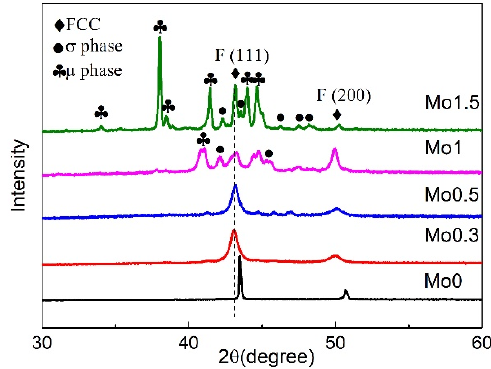
Figure 2. XRD patterns of the as-cast Mo x high entropy alloys. Table 1. Chemical composition of the different phases in the studied compounds (normalized molar ratio) . HEAs Analyzed Area